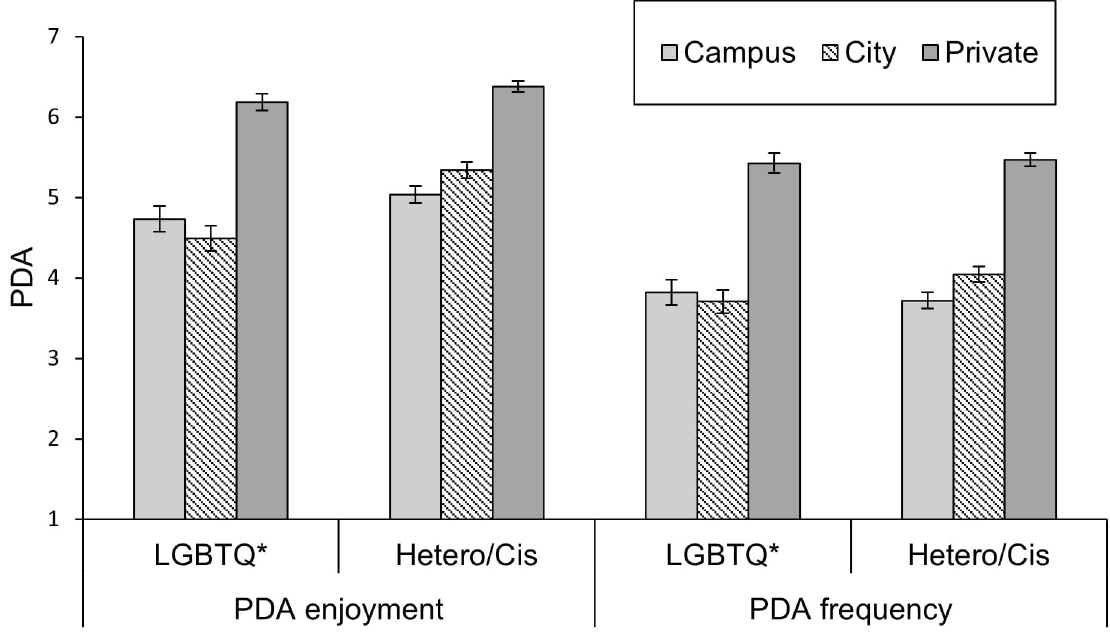
Fig 6. Reported enjoyment and frequency of physical affection by same-sex and different-sex participants in the contexts of a campus, a city, and a private setting in Study 3. Error bars represent +/– 1 SEM .